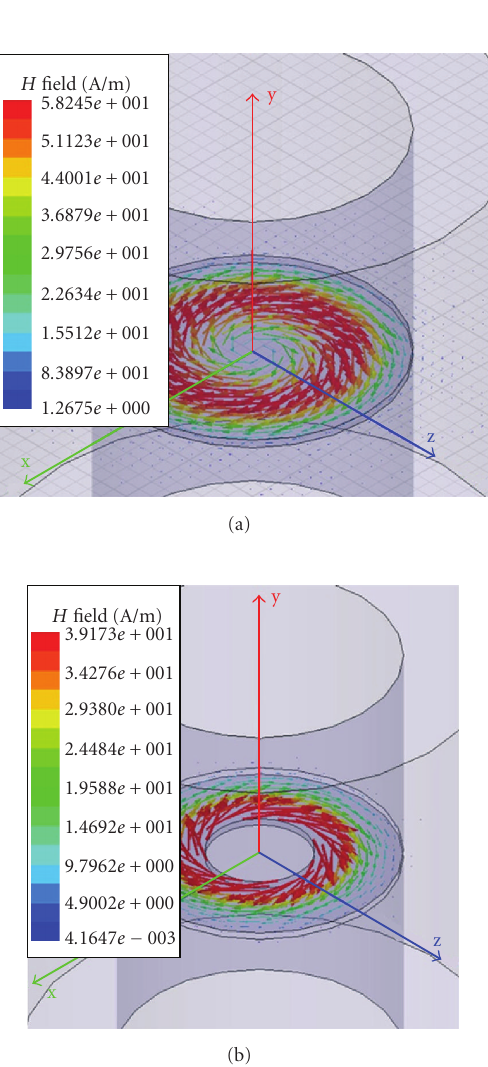
Figure 2: The magnetic field distribution in the slot: (a) d = a ; (b) d < a